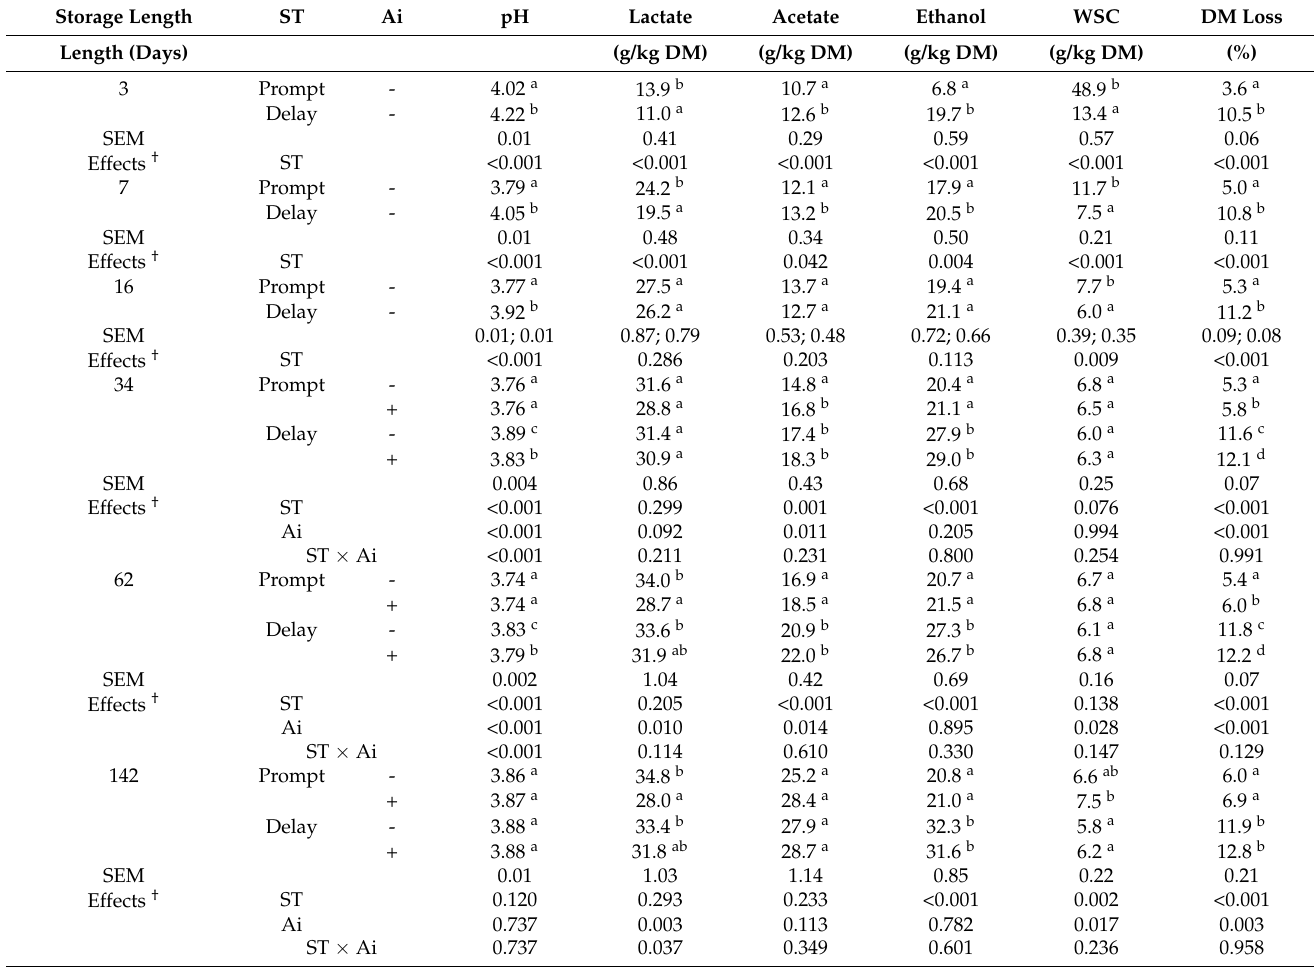
Table 2. Effects of sealing time (ST; 0 h = prompt vs. 24 h = delay) and air ingress (Ai) on fer- mentation characteristics and dry matter (DM) losses during the course of maize fermentation ( n = 6: d 3, 7, and 16; n = 5: d 16, ST = Prompt; n = 3: d 34, 62, and